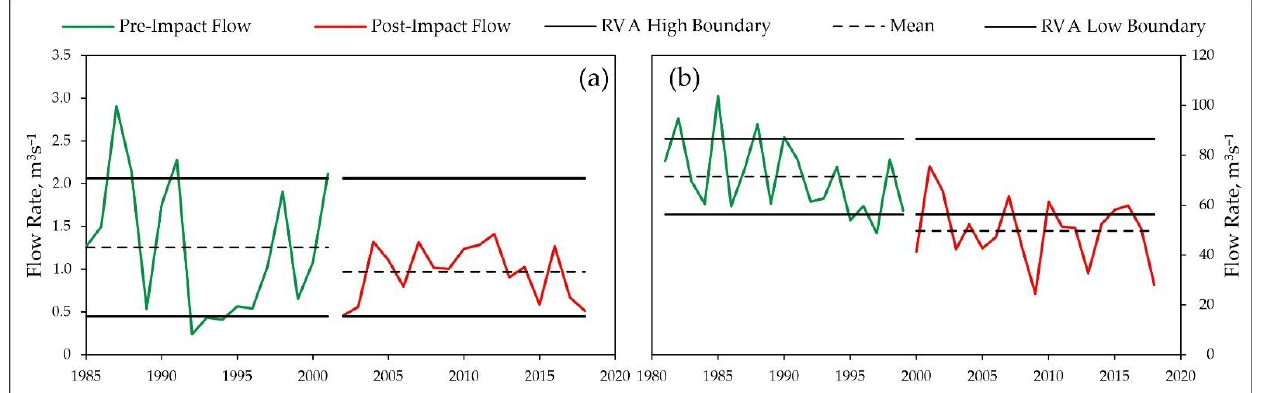
Figure 8. Hydrologic alteration of 7-day minimum ( a ) at Mūša -Ustukiai WGS and 3-day maximum ( b ) at Bartuva-Skuodas WGS.